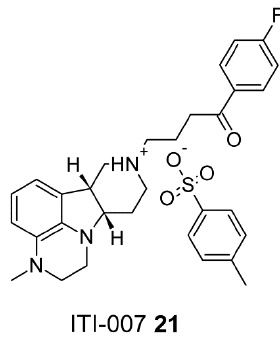
Figure 11. ITI-007, a potent 5-HT 2A receptor antagonist, postsynaptic D 2 receptor antagonist and inhibitor of serotonin transporter.